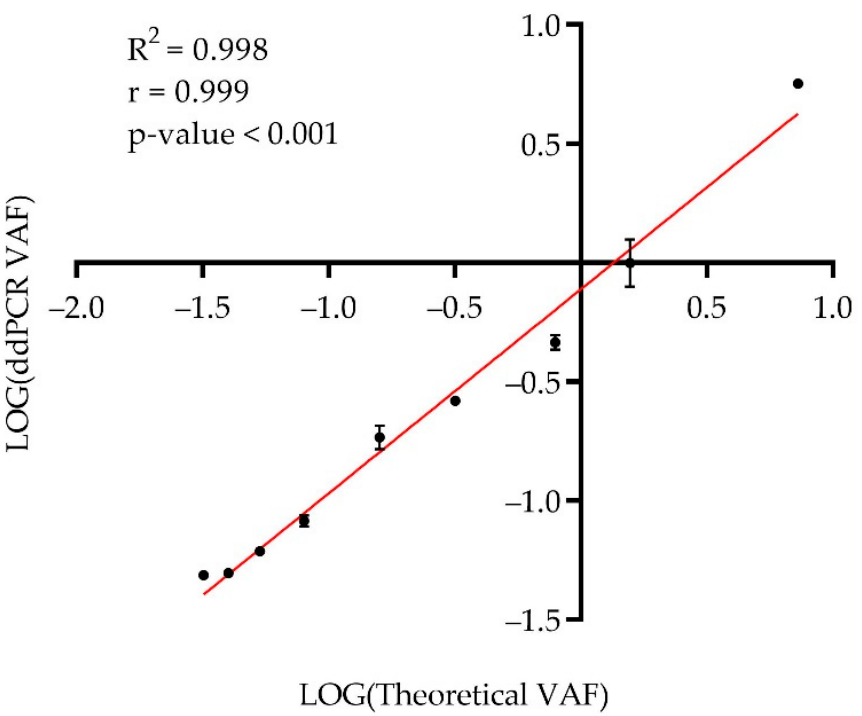
Figure 1. Correlation between theoretical VAF (%) and observed VAF (%) by ddPCR. Observed values are the mean of two independent experiments with error bars representing the standard deviation. Logarithmic transformation of both variables was applied to enhance visualization.